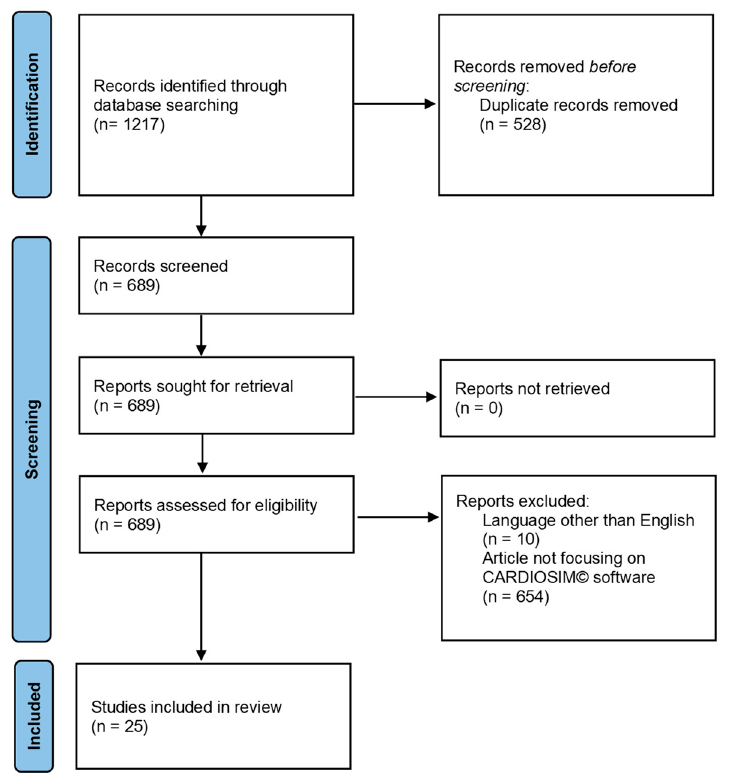
Figure 1. PRISMA flow chart obtained from the following link http://www.prisma-statement.org/documents/PRISMA_2020_flow_diagram_new_SRs_v1.docx (accessed on 29 May 2022).